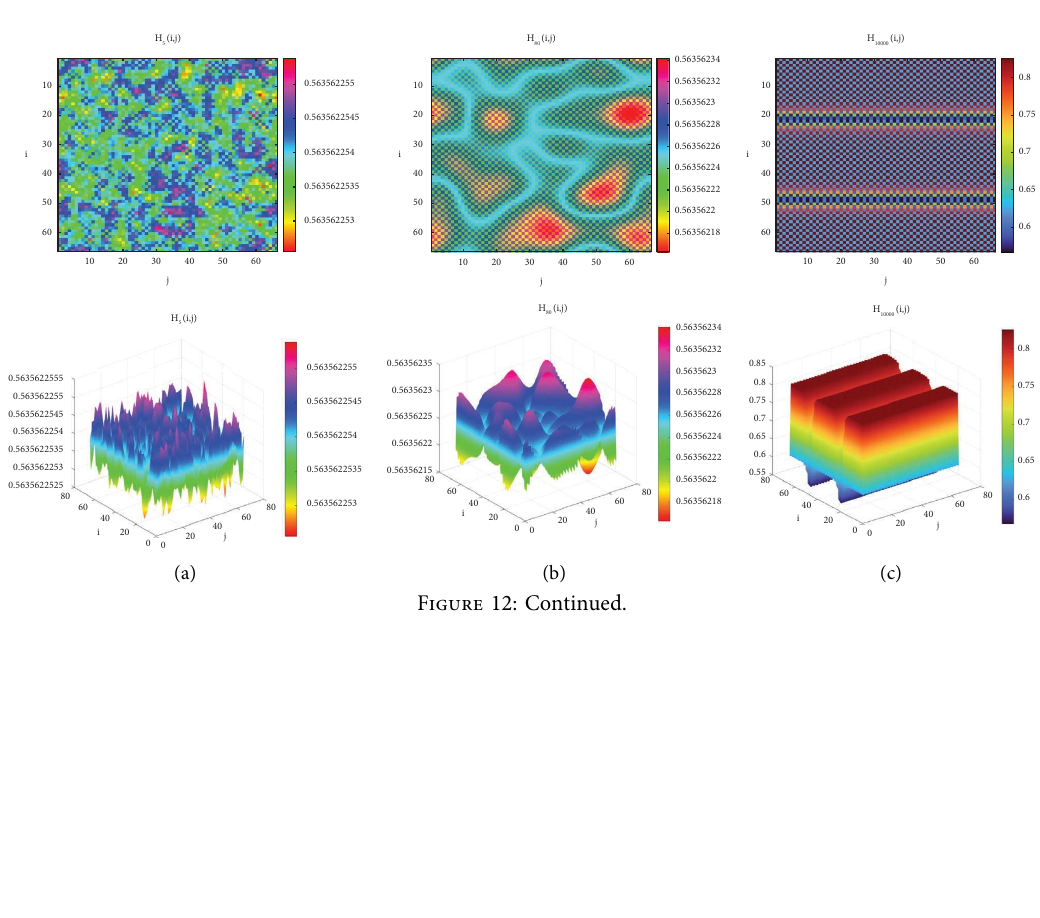
Figure 11: R � 2 , k � 1, c � 0 . 8, σ ∗ � 0 . 278655, d the case of Corollary 3(2), the pure Turing instability occurs, parasite and host populations are maintained in a relatively stable state in two- dimensional